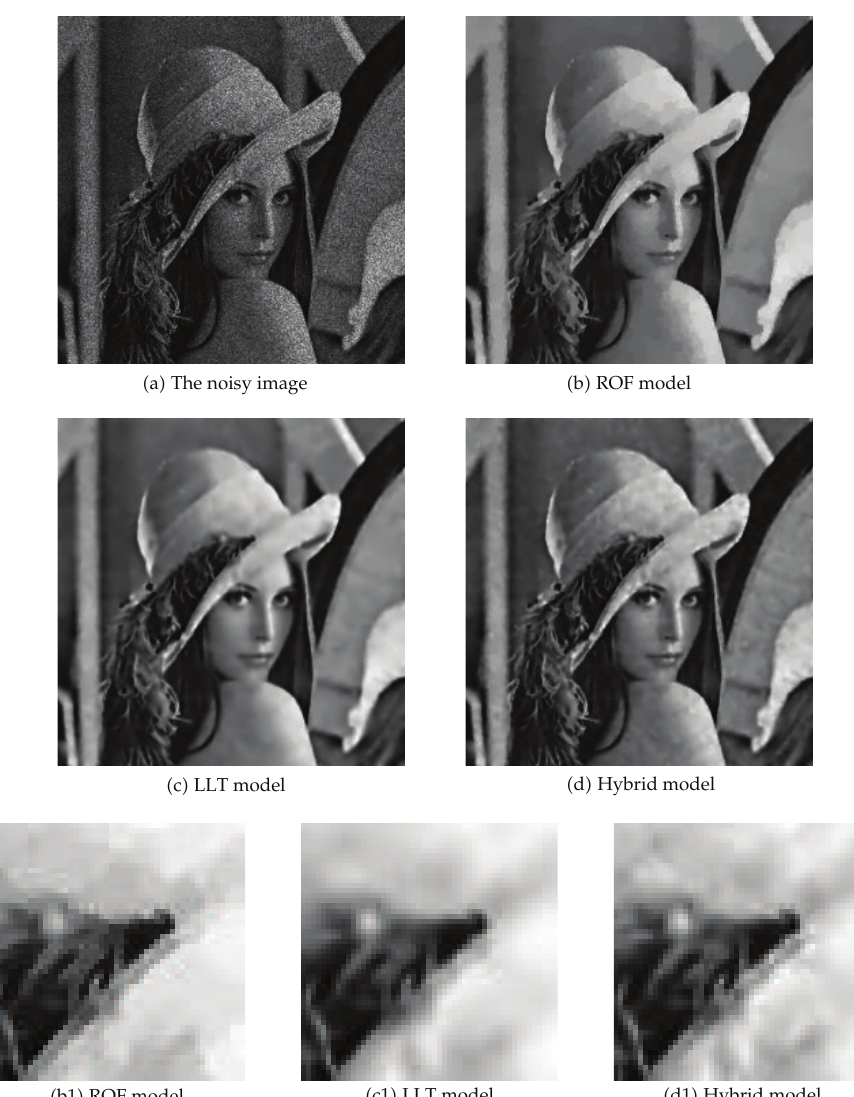
Figure 8: The related images and the local zooming images in Example 4.13. SNRs: (cid:3) a (cid:4) 9.2017; (cid:3) b (cid:4) 15.6059; (cid:3) c (cid:4) 15.1754; (cid:3) d (cid:4) 16.0546.